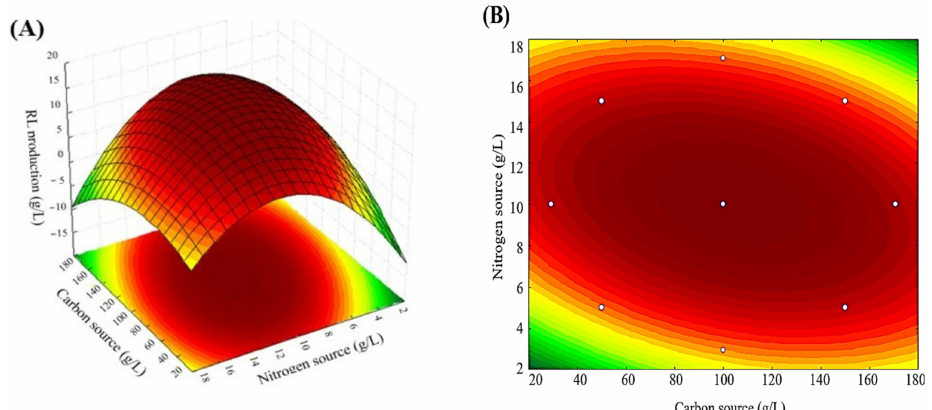
Figure 2. Response surface ( A ) and contour curve ( B ) for RL production by P. aeruginosa LBI 2A1 as function of carbon and nitrogen sources.